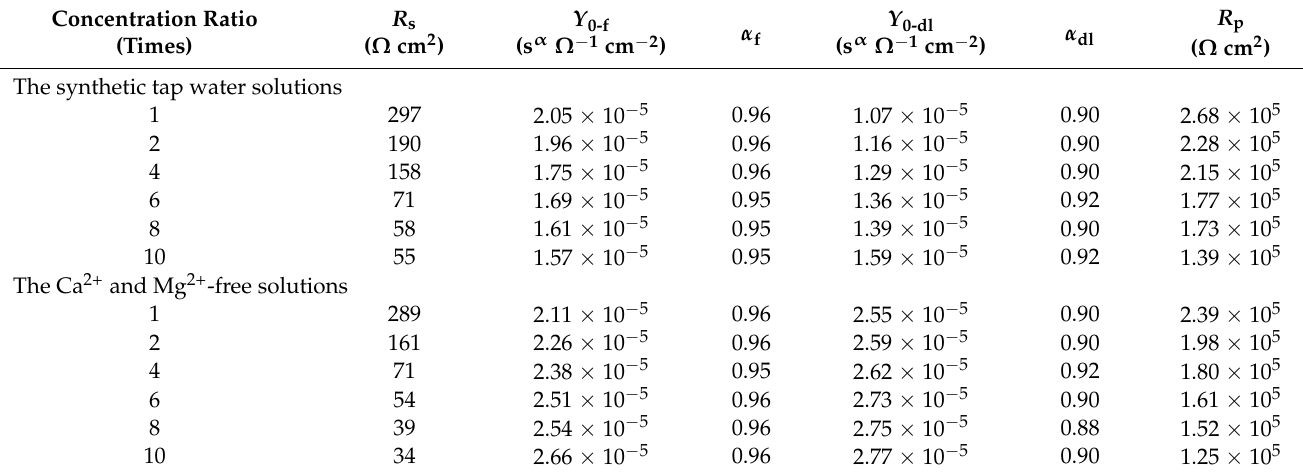
Table 2. Impedance spectrum fitting results of 310S stainless steel in two